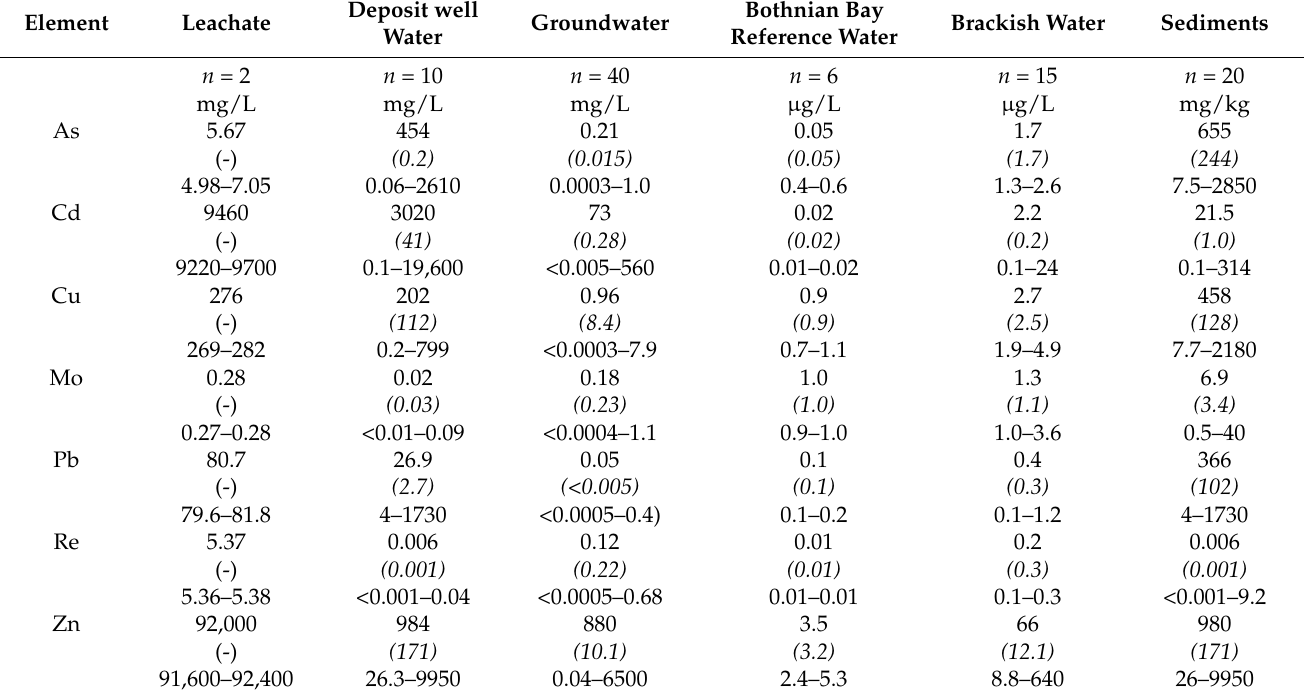
Table 2. Element concentrations in leachate, deposit well waters, groundwaters, Bothnian Bay background reference, brackish water sampled outside deposit facilities, and sediments from the transect outside the Rönnskär smelter. Values displayed as mean (median)